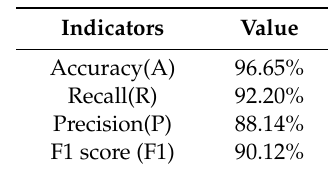
Table 12. Results of algorithm performance evaluation at event level: indicators.